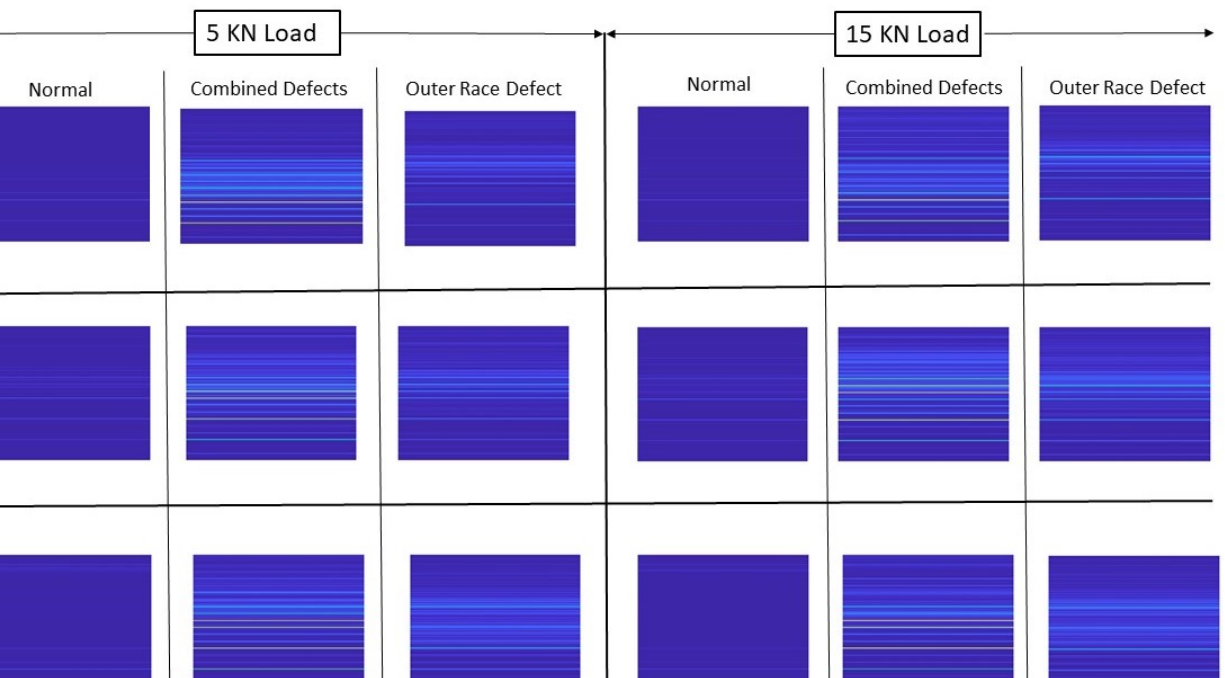
Figure 3. Order map under variable speed (3525–4125 rpm).